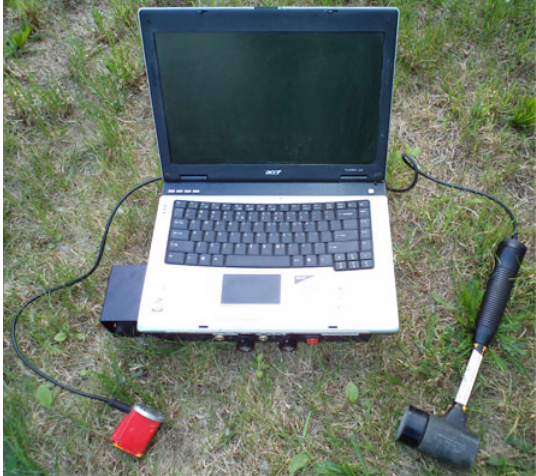
Fig. 3. Test equipment used in non-destructive acoustic impulse response